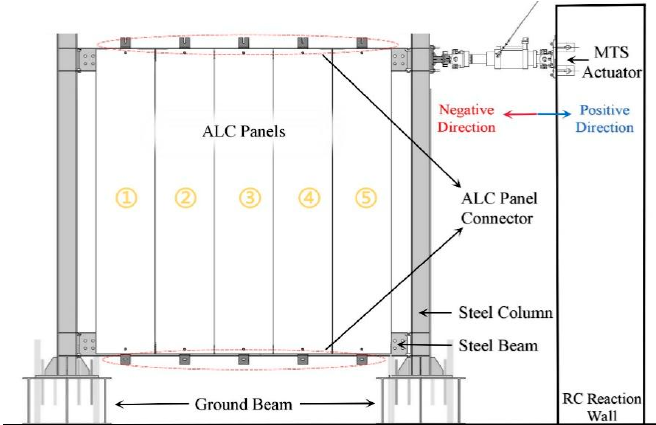
Figure 4. Test loading devices.